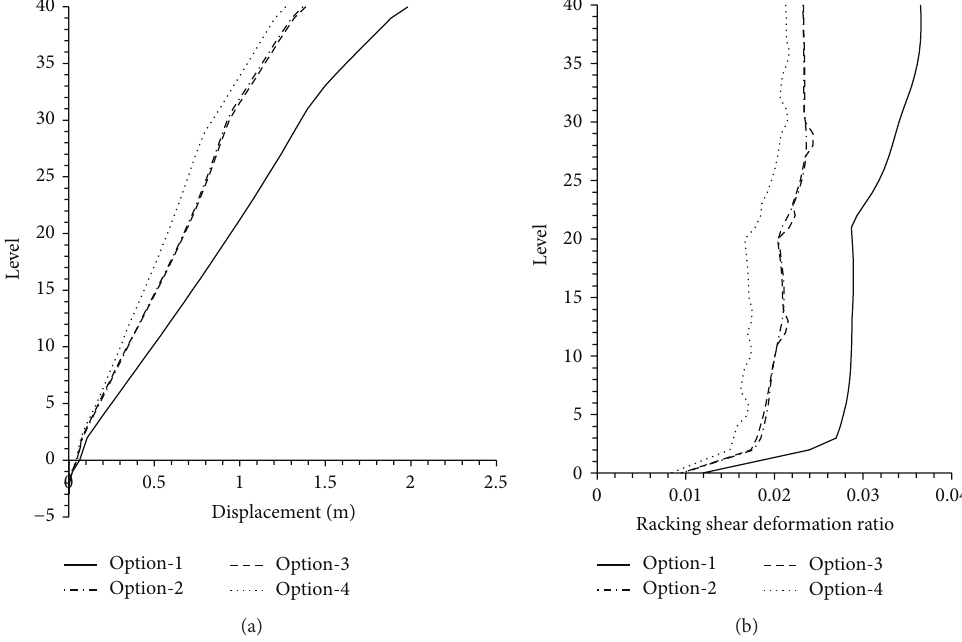
Figure 13: MCE inelastic displacement and racking deformation demands in different options. (a) Displacement; (b) racking shear deformation